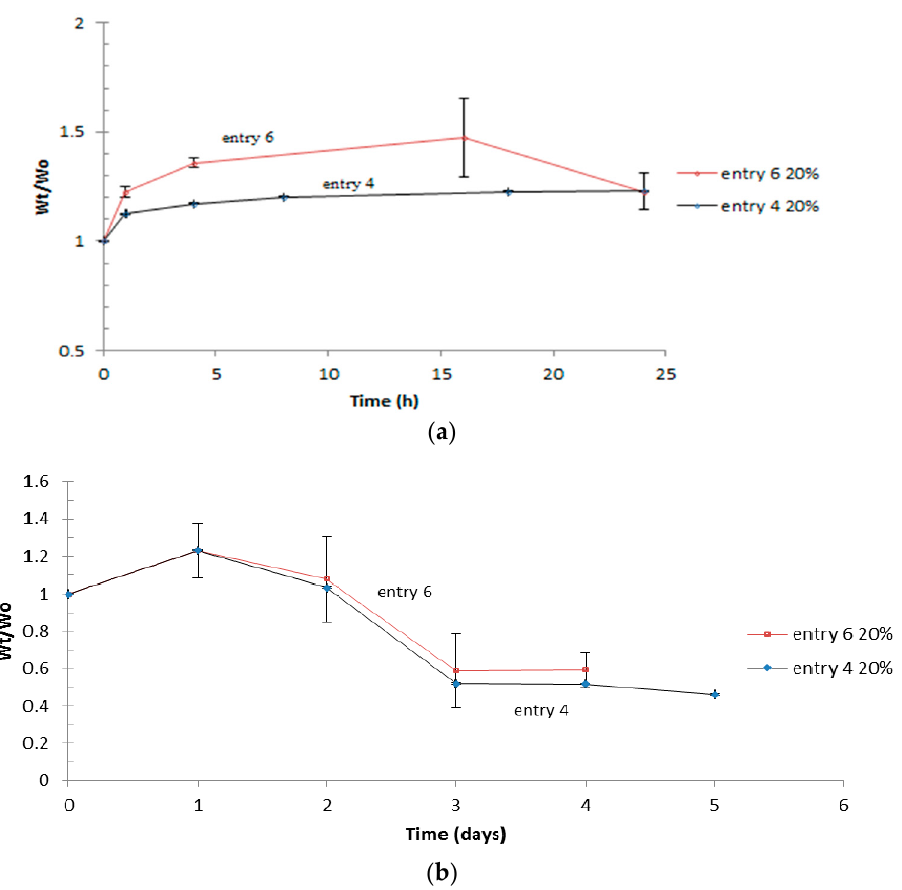
Figure 4. Swelling studies performed on chemically crosslinked 20% hydrogels prepared using R4 (entry 4, Table 1) and R6 (entry 6, Table 1) in PBS buffer (1 M, pH 7.4) at 37 °C. ( a ) in 24 h; ( b ) in 5